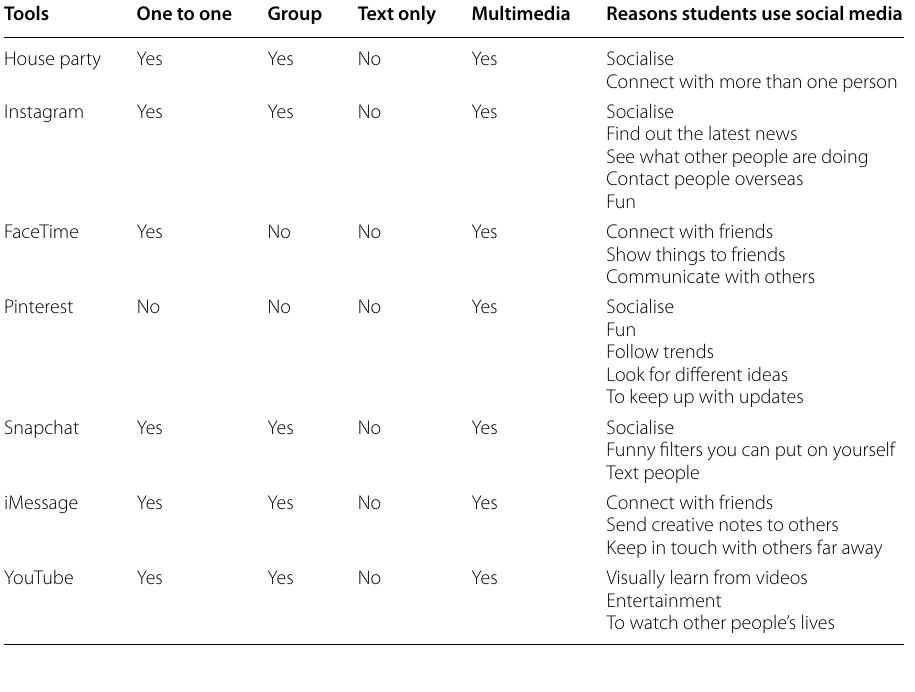
Table 2 An overview of the social media tools the students use and the reasons Tools